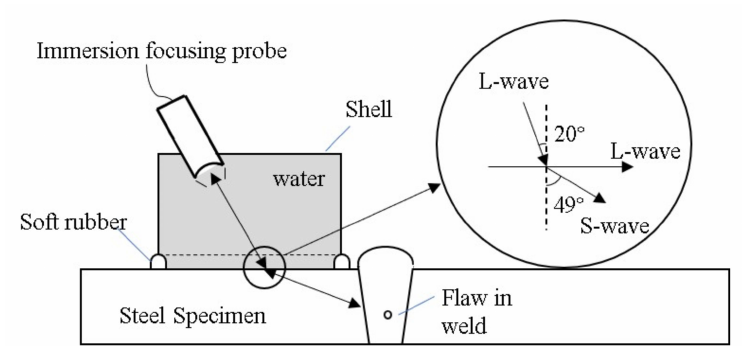
Figure 2. Schematic diagram of the designed PIF